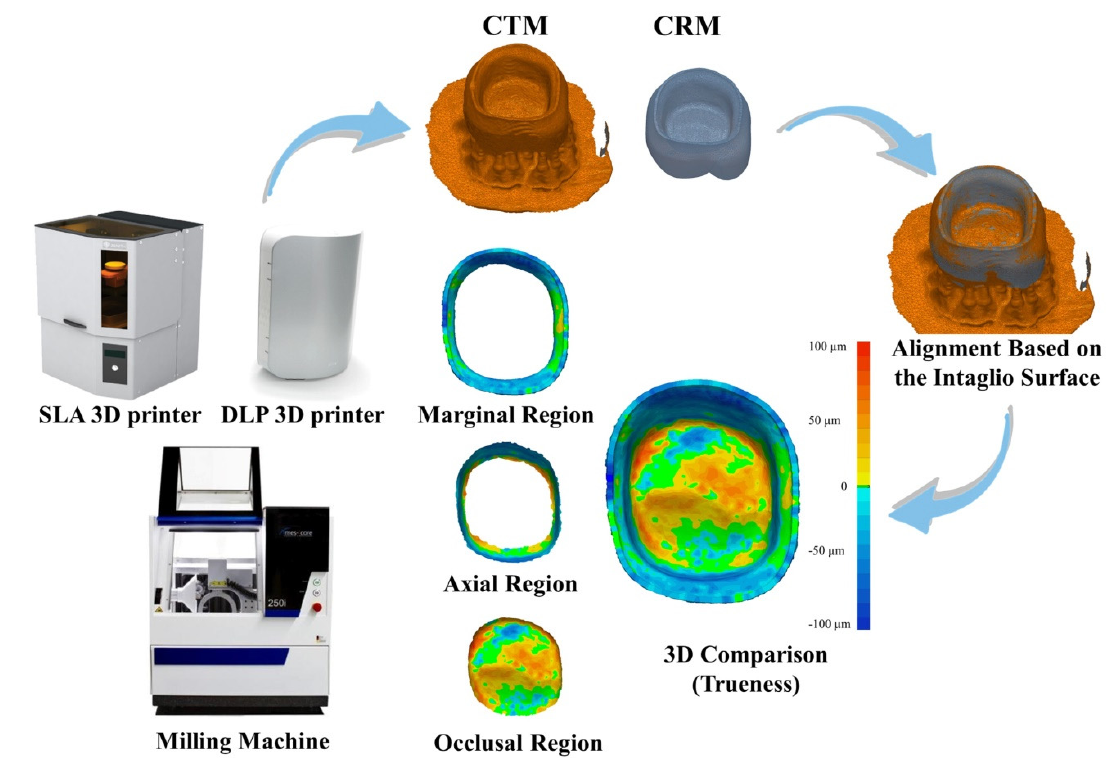
Figure 1. Procedure for intaglio surface trueness of interim crowns fabricated with SLA 3D printing, DLP 3D printing, and milling technologies.